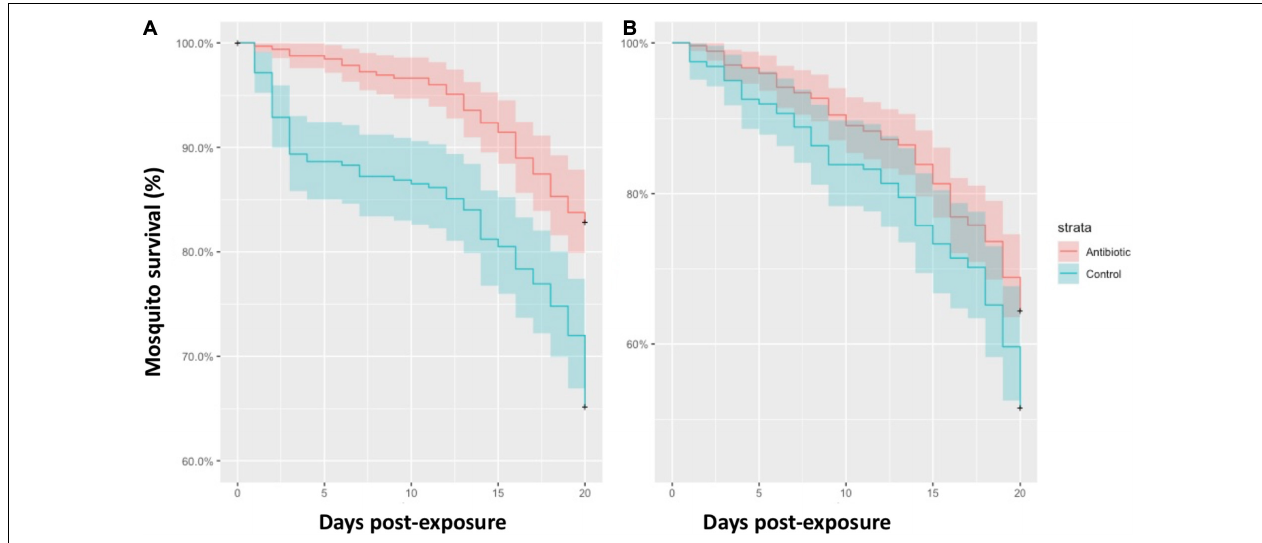
FIGURE 1 | Survival rate of mosquitoes treated with antibiotics (red lines) and control mosquitoes (blue lines) fed on Plasmodium infected birds (A) and uninfected birds (B) . Colored areas represent standard errors.